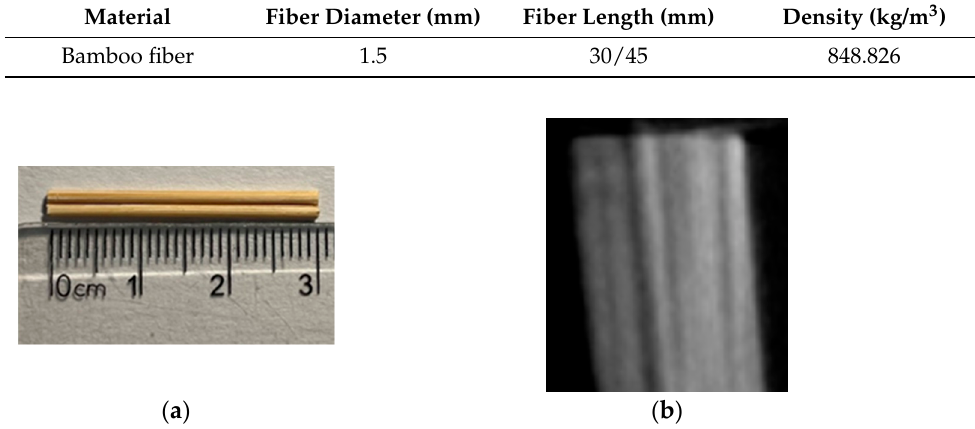
Table 2. Performance parameters of the bamboo fiber. Table 3. Mechanical properties of the BFRP bars.